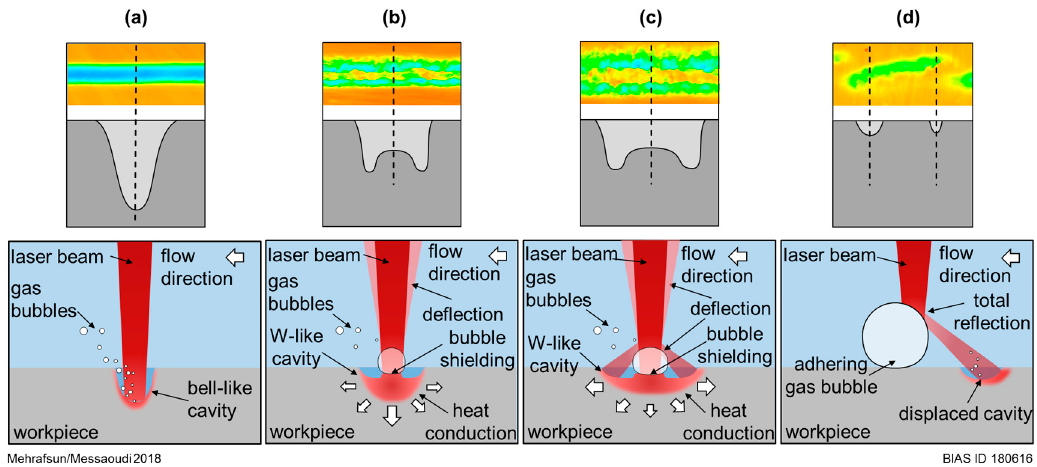
Figure 15. Characteristic removal profiles of the possible resulting LCM removal cavities (above) as well as schematic illustrations of the supposed dominating mechanisms (below) showing ( a ) a disturbance ‐ free removal and ( b – d ) a disturbed removal.